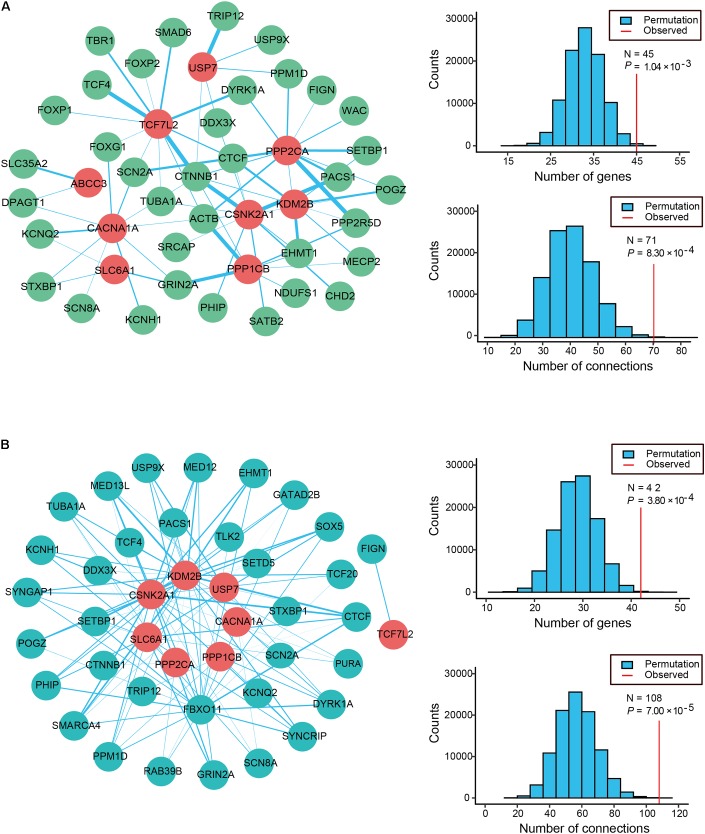
Protein–protein interaction (PPI) and co-expression network analyses of ID risk genes. (A) Physical interaction network was created by seeding 12 candidates and known ID genes with q-values < 0.3 in STRING. The node color reveals the class of the gene set (known ID genes, dark sea green; candidate ID genes, red), and the thickness of all edges with the color turquoise shows the degree of connectivity (PPI score). (B) The co-expression network between the 12 candidate ID genes (cyan) and the 63 known ID genes (firebrick) was analyzed using data from the HBT. Edge (blue line) size indicates the levels of co-expression of the gene pairs estimated by the absolute value of r greater than 0.6. The histograms describe the number of genes and connections distributing on the 100,000 interactions. Apart from that, the red vertical lines depict the numbers of observed nodes and connections in the networks. P-values are shown in the figures.